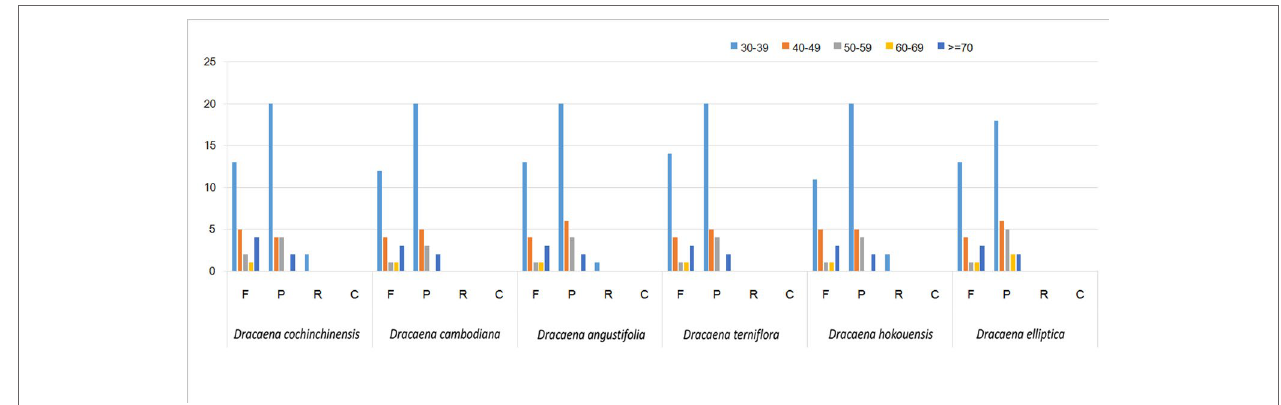
FIGURe 2 | Repeat analysis in six Dracaena complete chloroplast (CP) genomes. REPuter was used to identify repeat sequences with length ≥30 bp and sequence identified ≥90% in the CP genomes. F, P, R, and C indicate the repeat types F (forward), P (palindrome), R (reverse), and C (complement), respectively. Repeats with different lengths are indicated in different